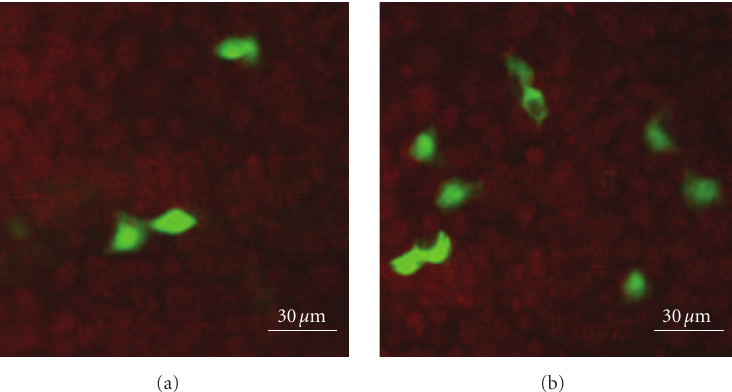
Figure 5: GFP detection by confocal microscopy . Polarized 16HBE41o- cells were incubated with 50 MOI LV (a) or with PEI/LV formulated at 1 × 10 7 ratio with 50 MOI LV (b). 72 hours later cells were stained with propidium iodide and analyzed by confocal microscopy. GFP-positive cells are in bright green while nuclei are stained in red. Note an approximately 3-fold increase in GFP-positive cells in B as compared to A. En-face micrographs are shown. Bar: 30 μ